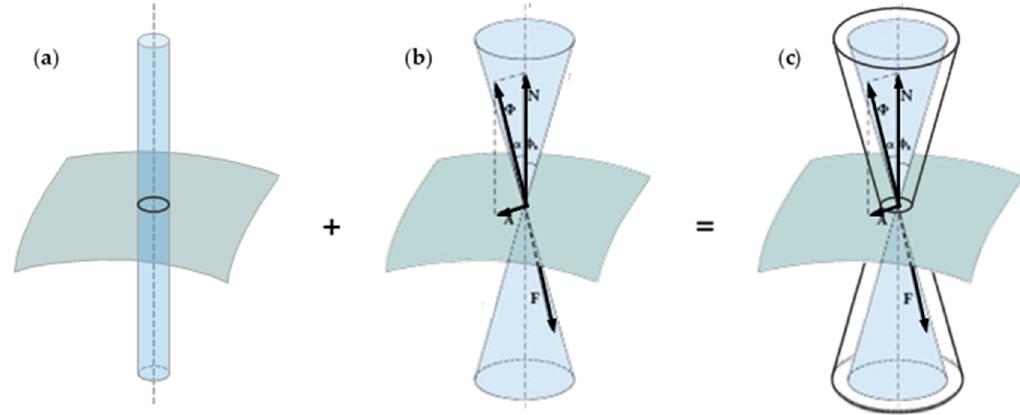
Figure 1. How the addition of a physical bond–represented by ( b ) the conical limit surface of static friction–changes the limit surface in static conditions from ( a ) the cylindrical surface of the chemical bond to ( c ) the double truncated cone of the cohesive static friction [1].